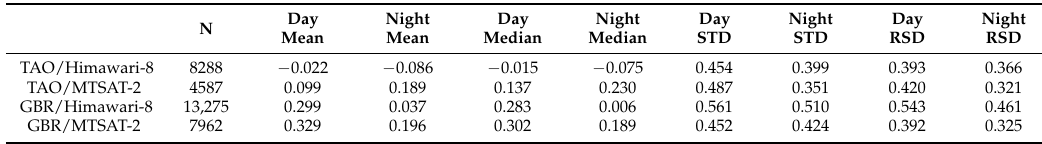
Table 6. Statistics of satellite SST—in situ temperatures (K) for day and night conditions at the positions of the Tropical Atmosphere Ocean (TAO) moorings and the Great Barrier Reef (GBR) stations. Day Night Day Night Day Night N Mean Mean Median Median STD STD